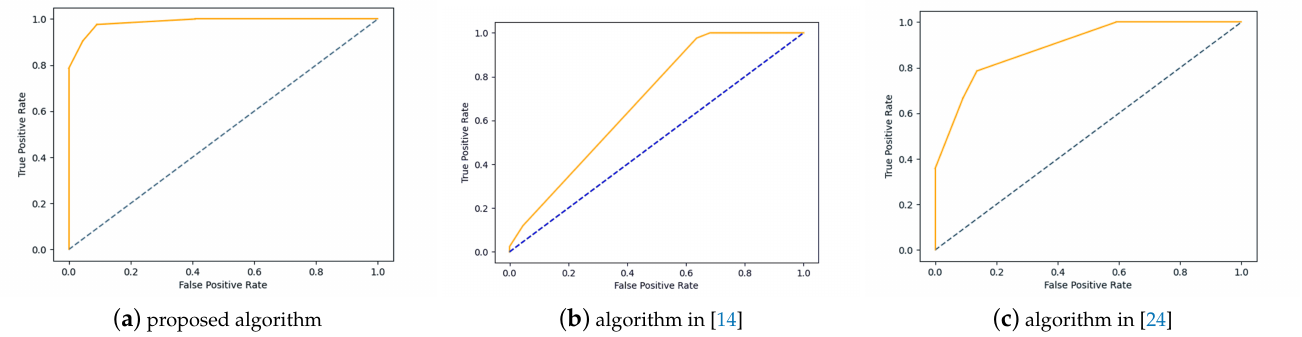
Figure 16. The ROC curve for the inspection of gold finger area for various algorithms: ( a ) ROC curve of the proposed algorithm, ( b ) ROC curve for algorithm in [14], ( c ) ROC curve for algorithm in